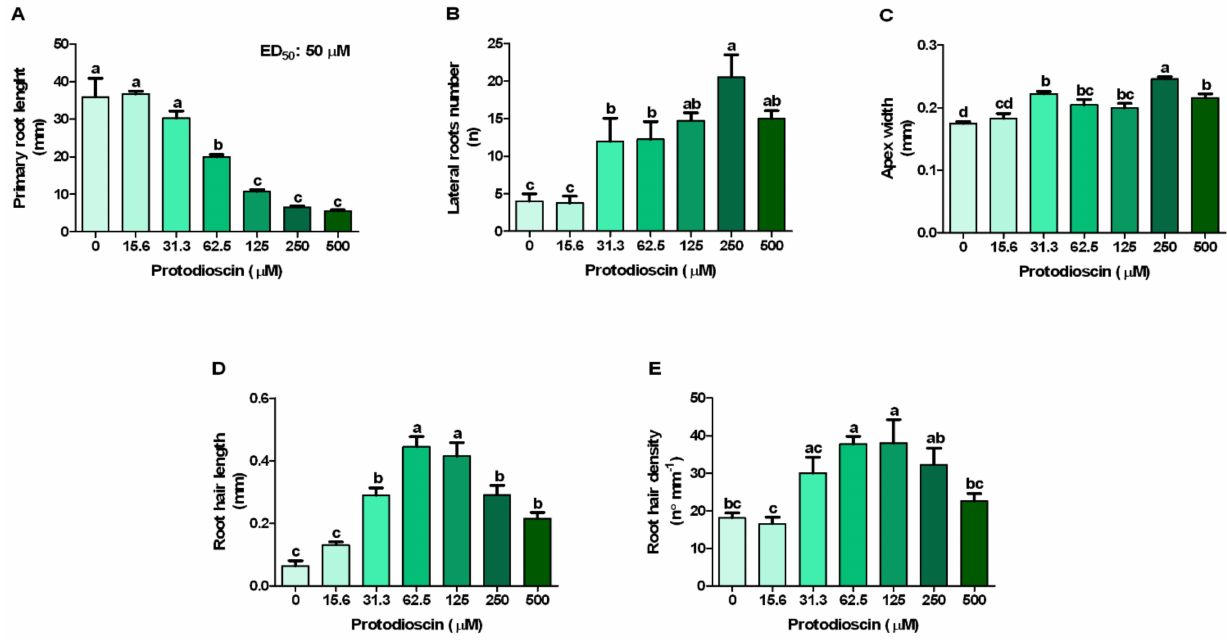
Figure 1. Arabidopsis roots morphology in response to the increasing doses of protodioscin: ( A ) primary root length; ( B ) lateral roots number; ( C ) apex width; ( D ) root hair length, and ( E ) root hair density. ED 50 : dose causing 50% reduction of primary root length. Different letters indicate significant differences observed among treatments at p ≤ 0.05 (SNK’s test). N =